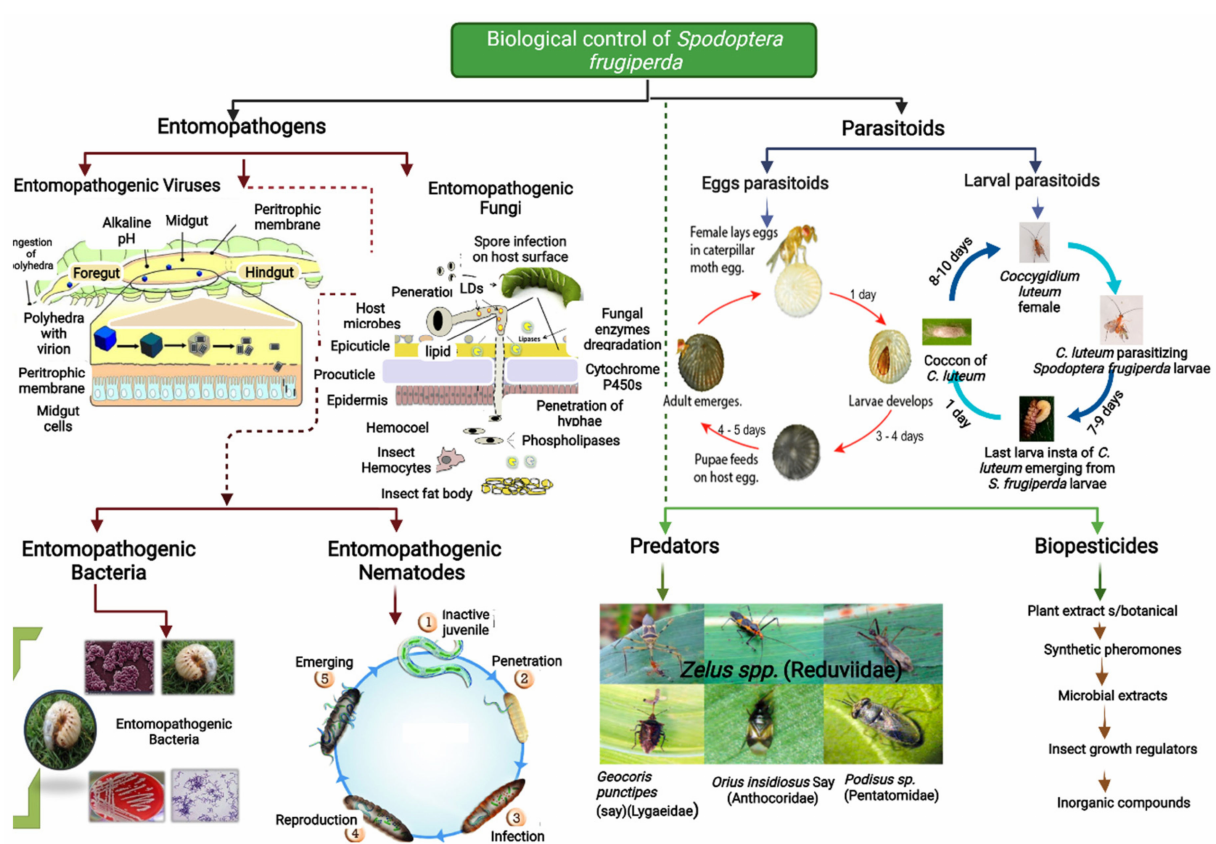
Figure 1. Biological control of fall armyworm (FAW), Spodoptera frugiperda . Biological Control agent: a contemporary release against